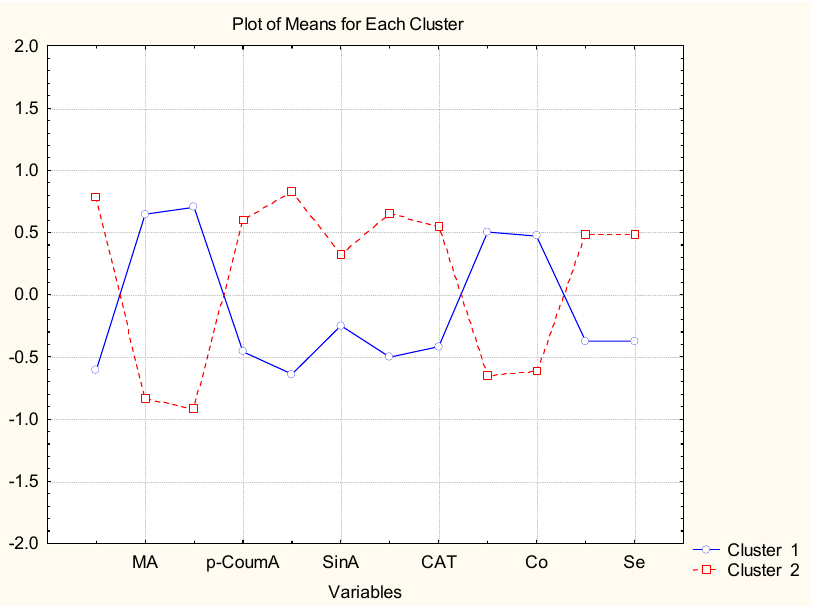
Figure 4. Plot of mean values (standardized) for each selected descriptor (final reduced number) for each identified cluster.